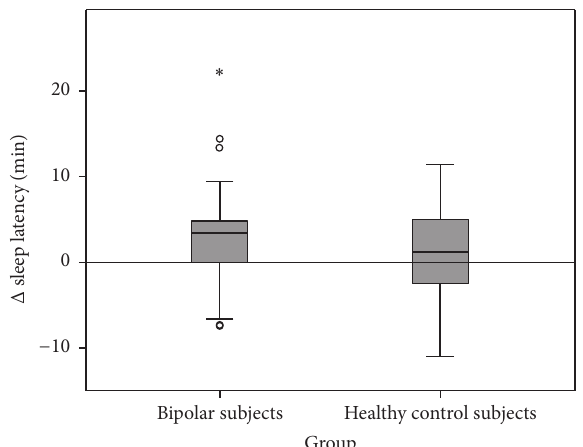
Figure2: Δ sleeplatency.Discrepancybetweenactimetricallydeter- mined values and sleep diary. Positive values indicate subjective overestimation of sleep